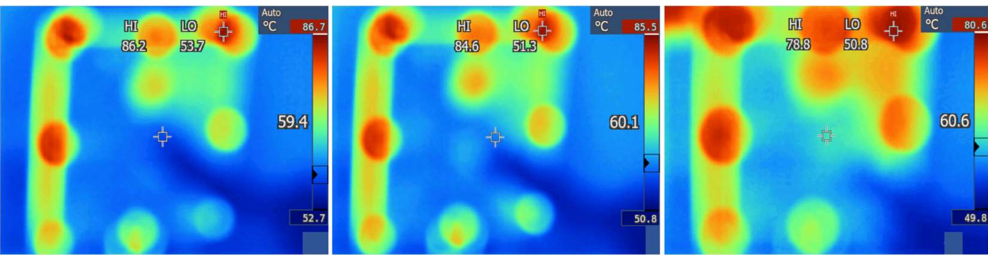
Figure 8. Thermographic distribution of aluminum flat plate models (1) to (3) at Re = 17,000.